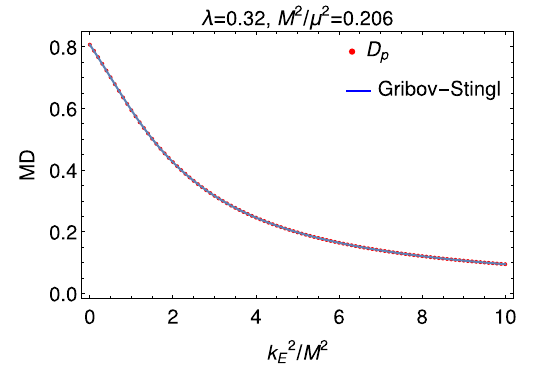
Fig. 20 The comparison between the pole part of the gluon propagator (red dotted line) and the fit to the Gribov–Stingl form (blue solid line), at the physical values of the parameters λ = 0 . 32, M 2 /μ 2 = 0 . 206